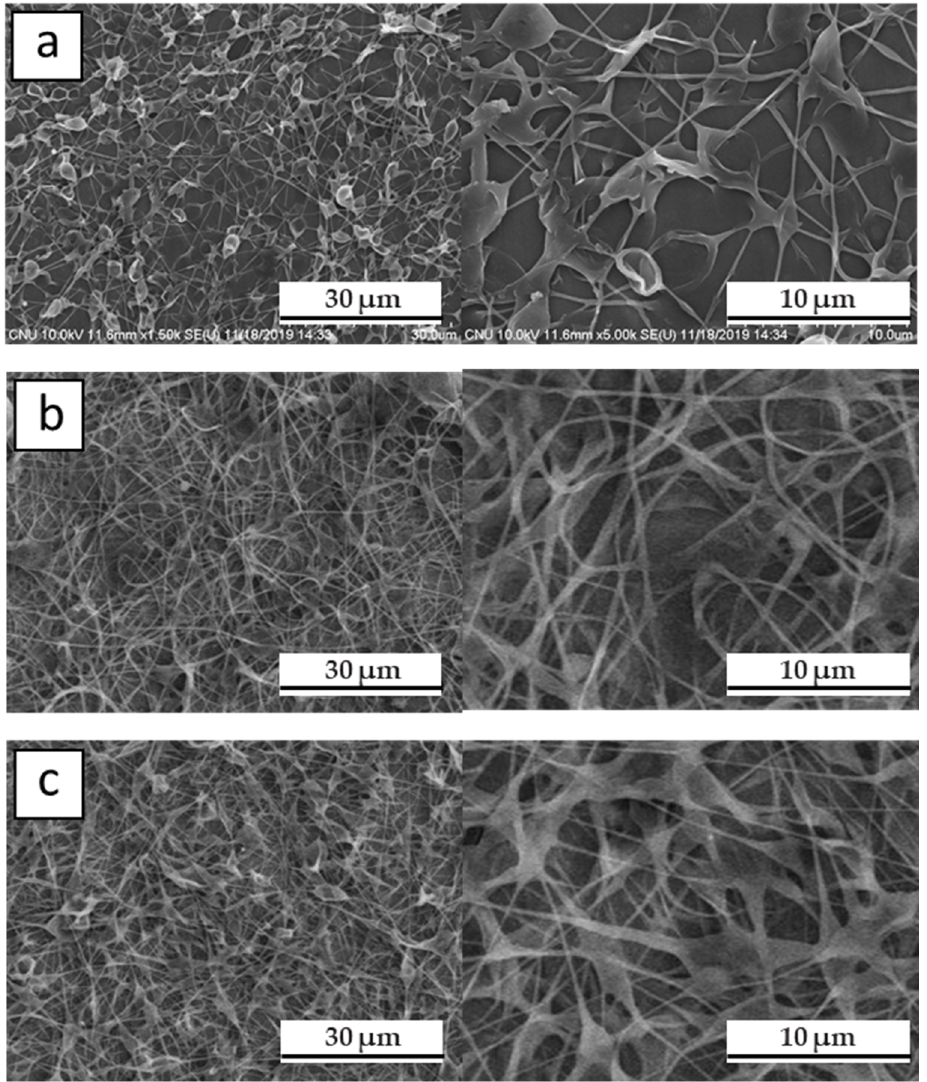
Figure 2. SEM images of electrospun hPB fiber with different volume ratios: Cyclohexane/THF/DMF ( a ) 1:1:0.1, ( b ) 1:1:0.2 and ( c ) 1:1:0.3.